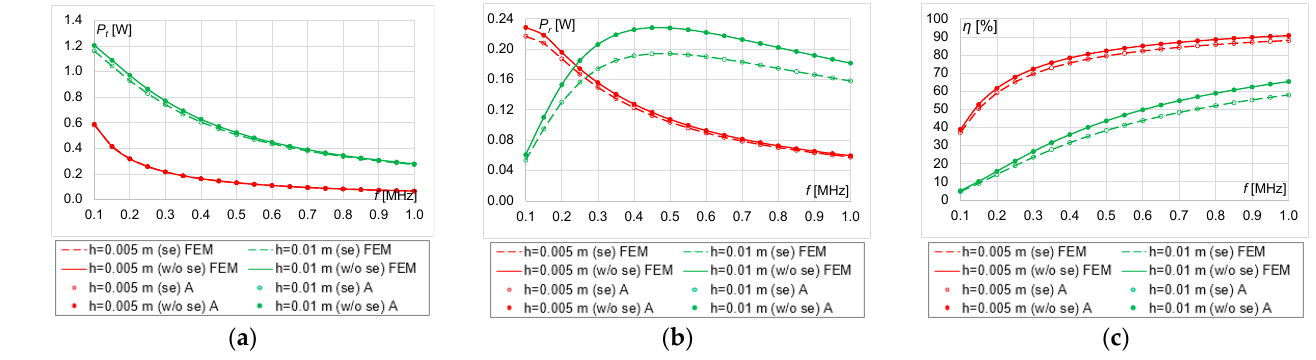
Figure 9. Results for n = 20 for the cases with and without skin effect: ( a ) P t , ( b ) P r , ( c ) η .